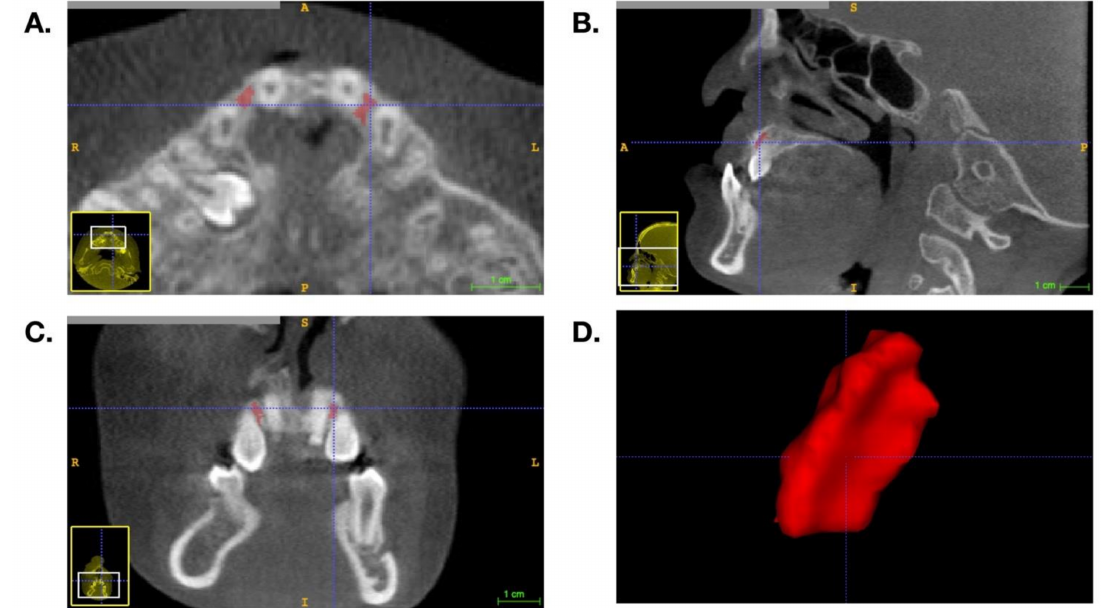
Figure 3. Volumetric analysis of the grafted tissue using ITK-SNAP 3.6.0 open-source software. ( A ) The axial view of the grafted tissue. ( B ) The sagittal view of the grafted tissue. ( C ) The coronal view of the grafted tissue. ( D ) The 3D display of the grafted tissue after